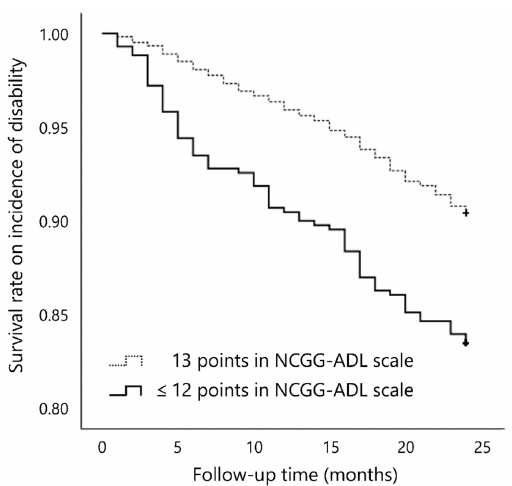
Figure 1. Estimates of survival rate on disability incidence according to score on the NCGG-ADL scale at baseline.